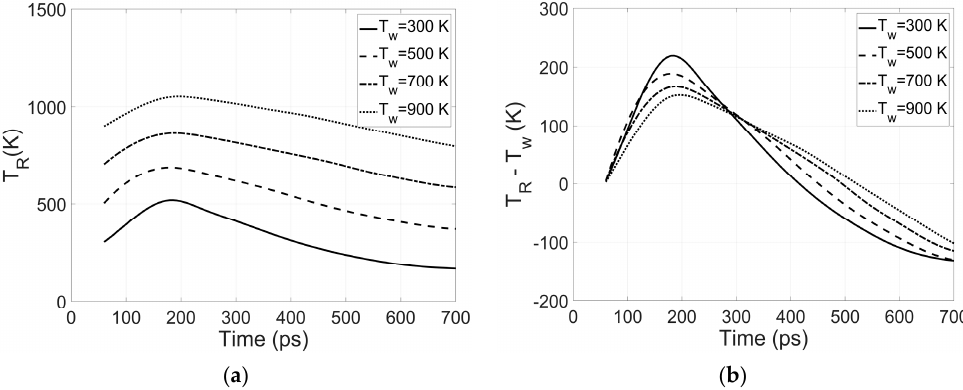
Figure 10. ( a ) T R and ( b ) T R − Tw vs. time for various workpiece temperatures.